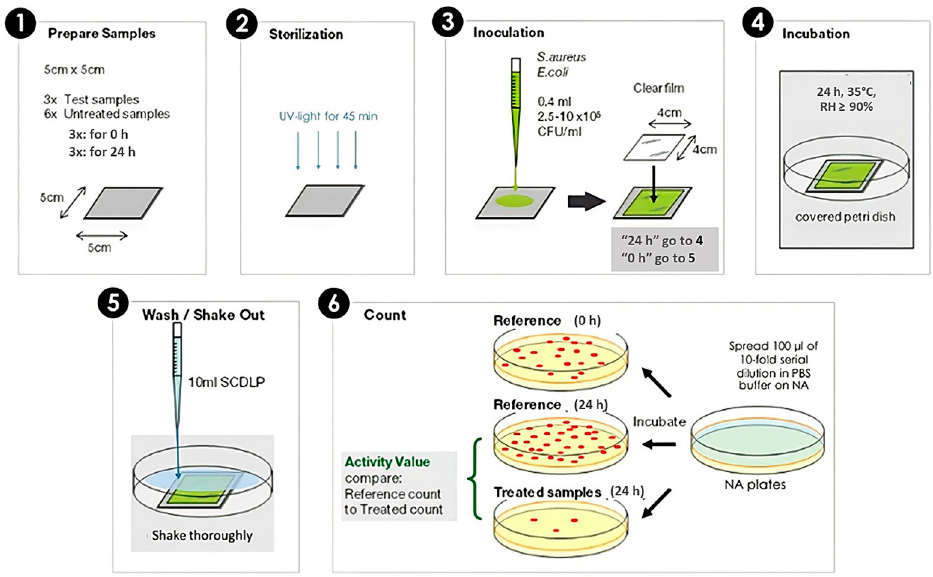
Figure 1. Schematic of antibacterial activity testing by ISO 22196 modified standard (Microbe Investigations AG, 2012–2020).